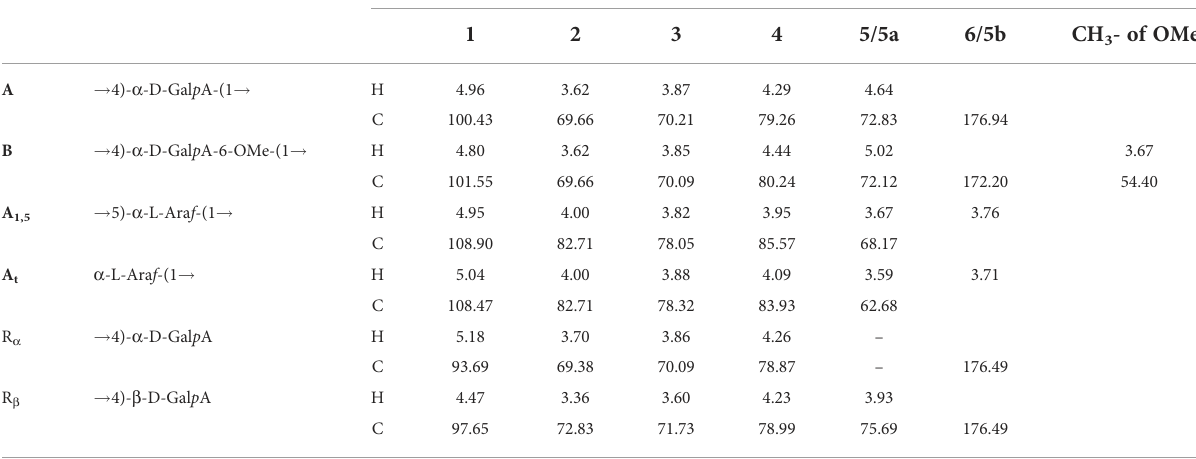
TABLE 3 Assignment of chemical shifts of 1H and 13C of each sugar residue in GPS-1. sugar